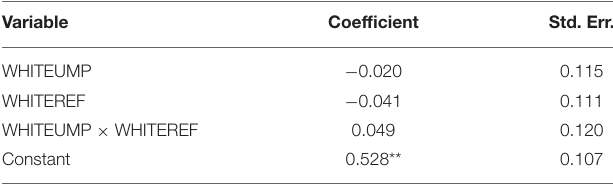
TABLE 4 | Game-level linear regression. Variable Std.